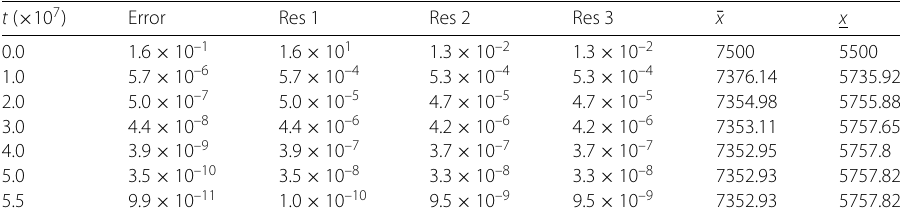
Table 2 Time evolution of the error, the residuals and the computed thresholds t ( × 10 7 ) Error Res 1 Res 2 Res 3 ¯ x x